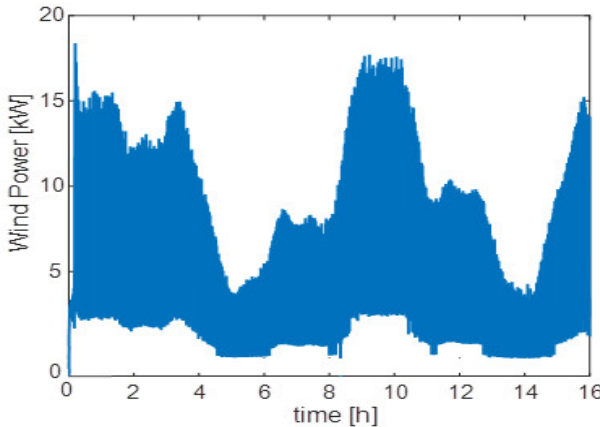
Figure 12. Power of the wind turbine at the point of coupling.